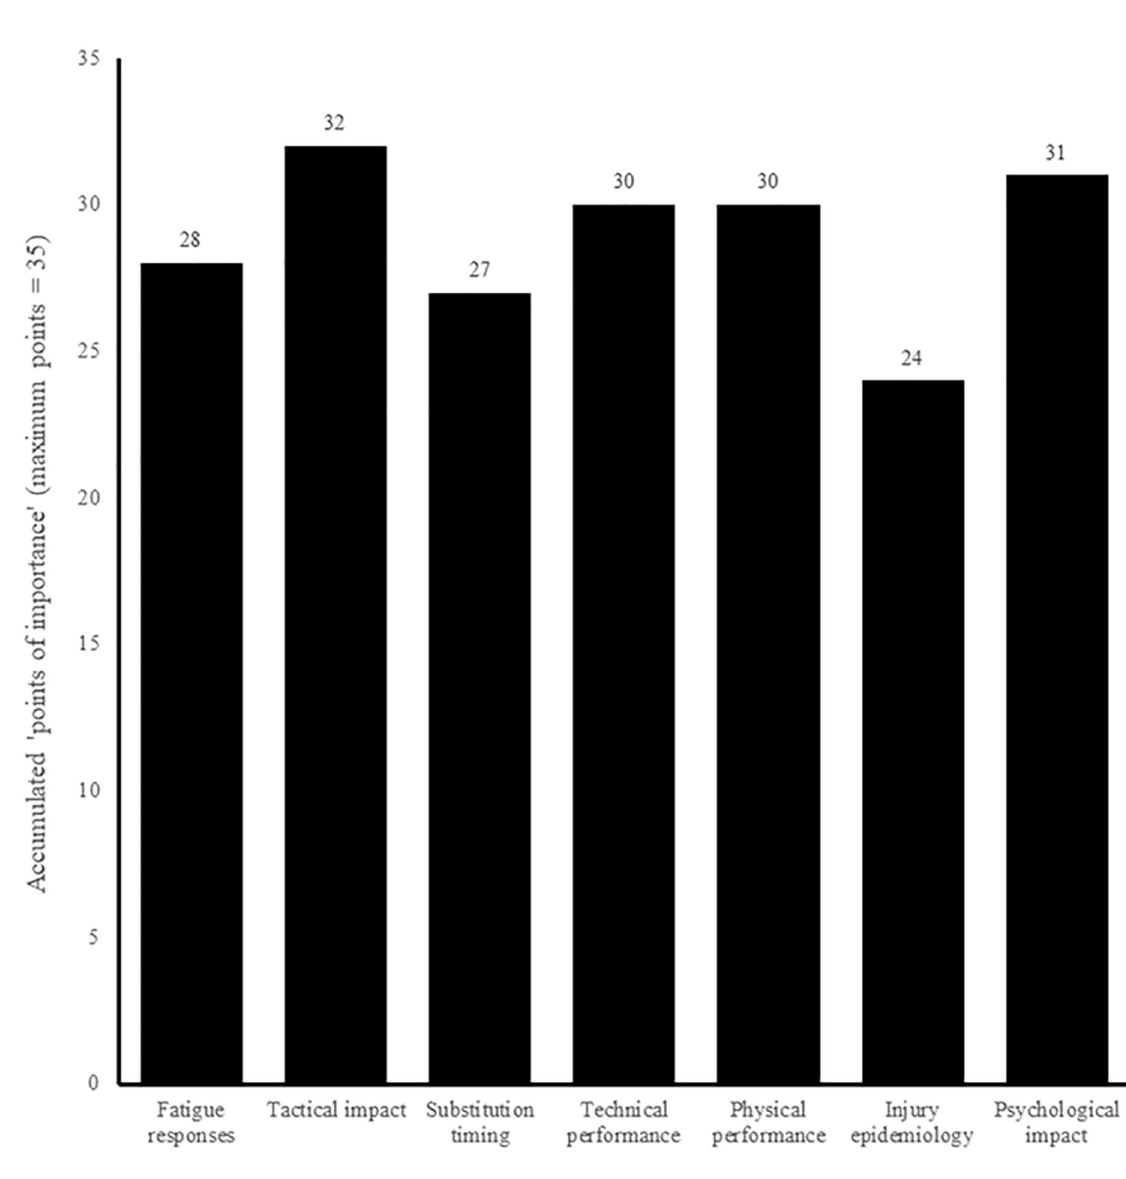
Fig 10. Tactical practitioners’ perceived importance of areas for future research (n =